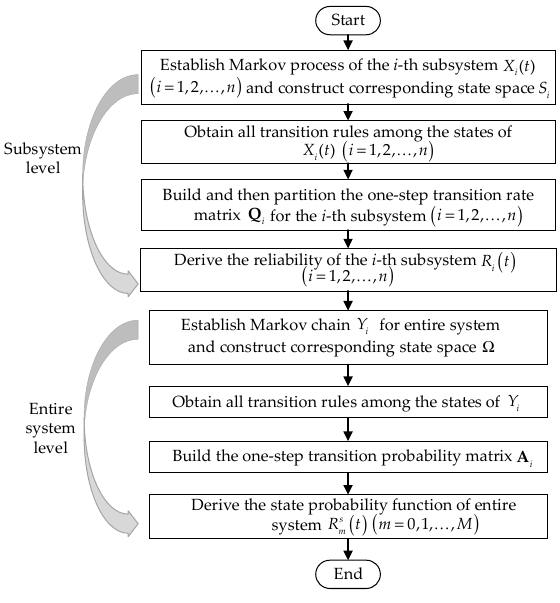
Figure 3. Flow chart of reliability evaluation steps.